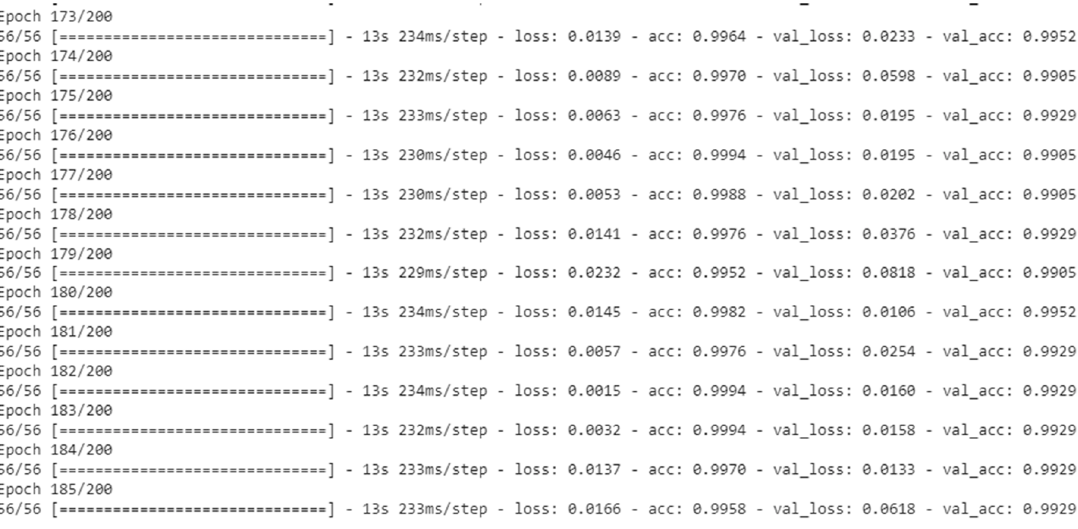
Figure 7. Showing ResNet152 training process using fine-tuning.